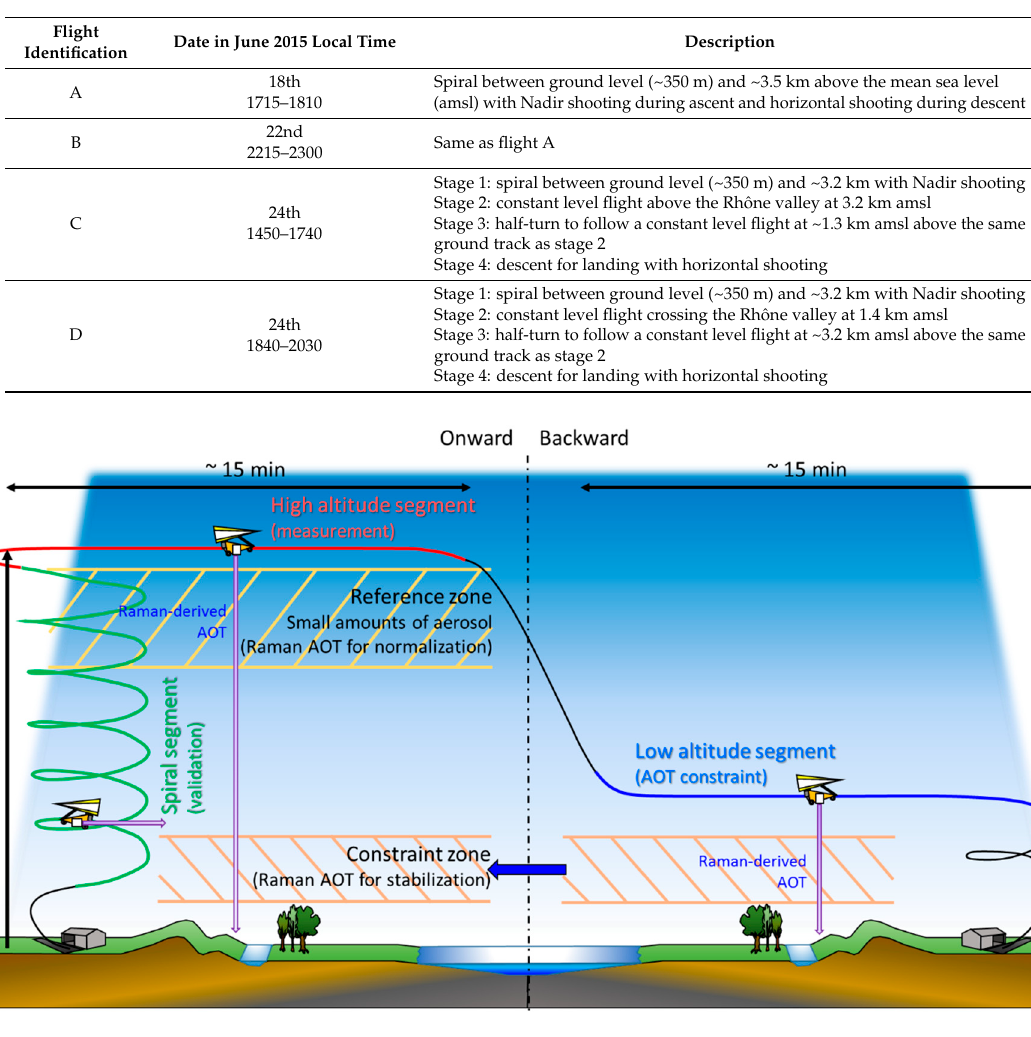
Table 1. Flight information: identification, date and description of flights performed.